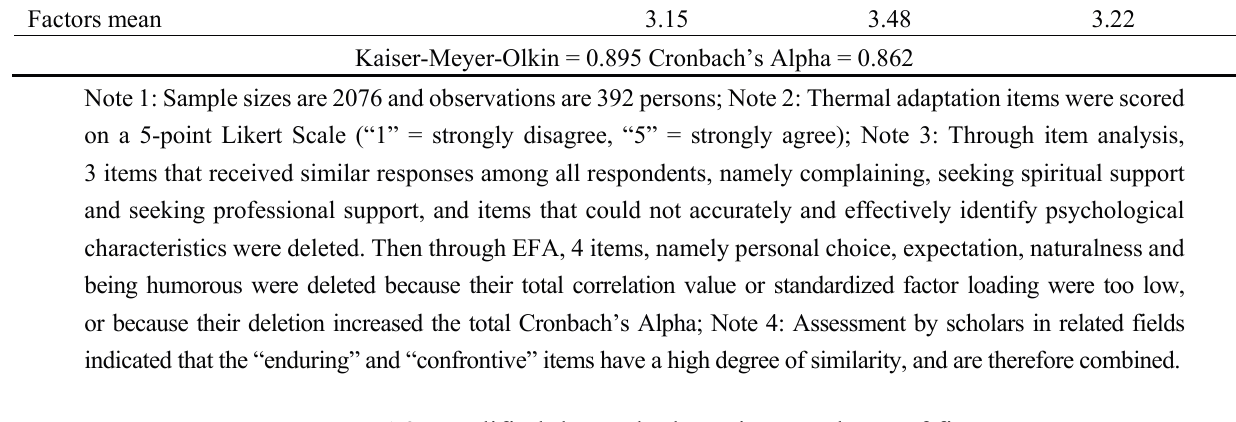
Table A3. Modified thermal adaptation goodness of